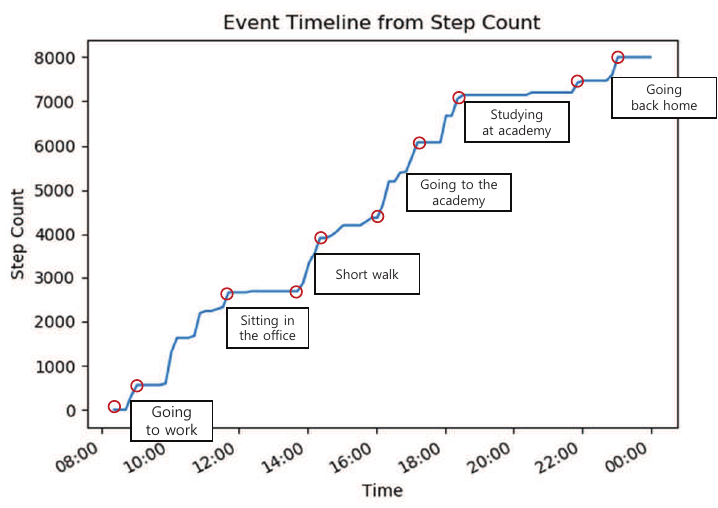
Figure 1. An example of the change in daily cumulative step-count per hour that is measured by a wearable